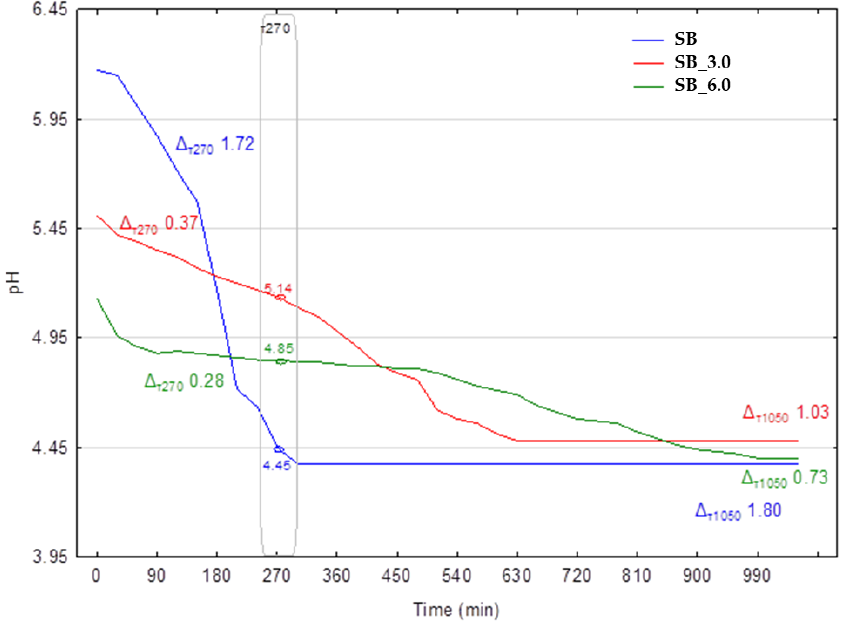
Figure 1. pH changes during the fermentation of soy beverages with acai powder. SB: fermented soy beverage; SB_3.0: fermented soy beverage with 3% acai powder; SB_6.0: fermented soy beverage with 6% acai powder. Figure was prepared using the Statistica data analysis software. Table 1. Kinetic characteristics of fermentation soy beverages with acai powder. SB SB_3.0 SB_6.0 V m (pH/min) 0.0069 c 0.0030 a 0.0057 b 210 b 840 c